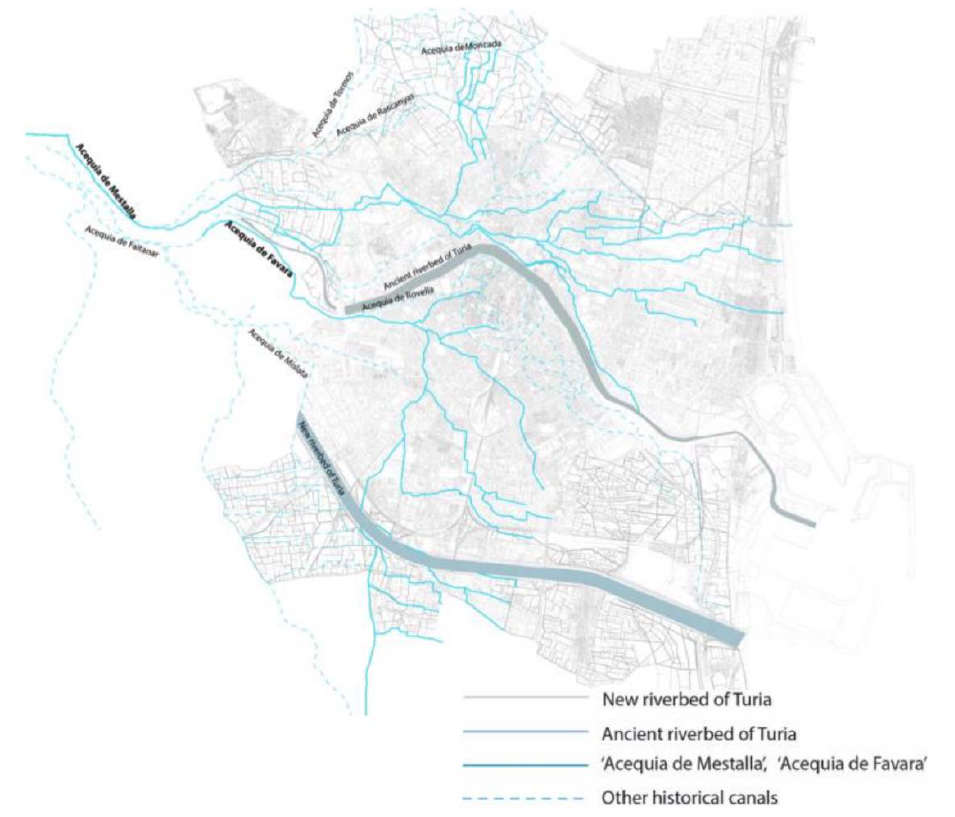
Figure 1. Protected irrigation canals and present urban